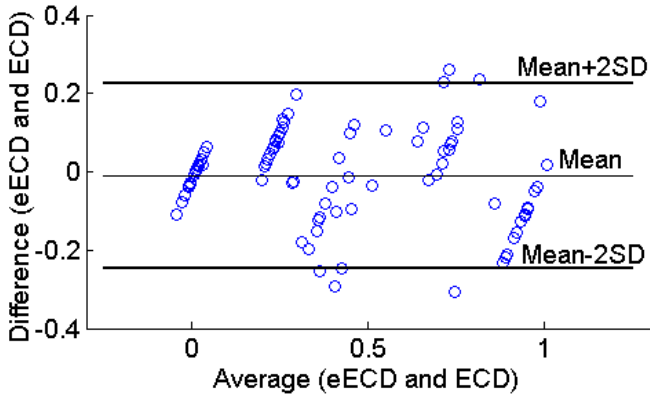
Figure 15. Bland-Altman plot for the relationship of the difference between the observed ECD versus estimated ECD versus their average values. Mean bias (—), +2SD, and − 2SD lines are shown. SD = standard